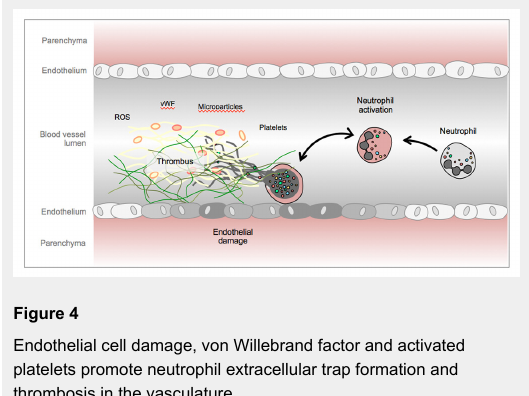
Endothelial cell damage, von Willebrand factor and activated platelets promote neutrophil extracellular trap formation and thrombosis in the vasculature. ROS = reactive oxygen species; vWF = von Willebrand